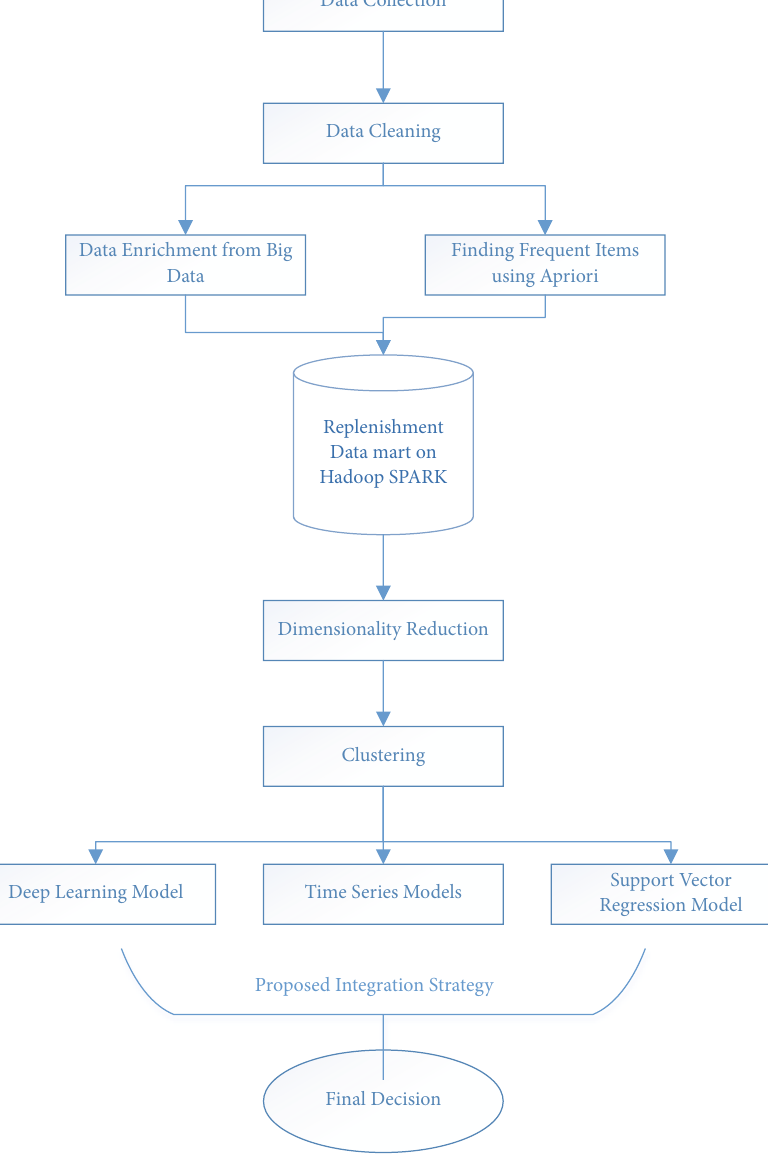
Figure 1: Flowchart of the proposed